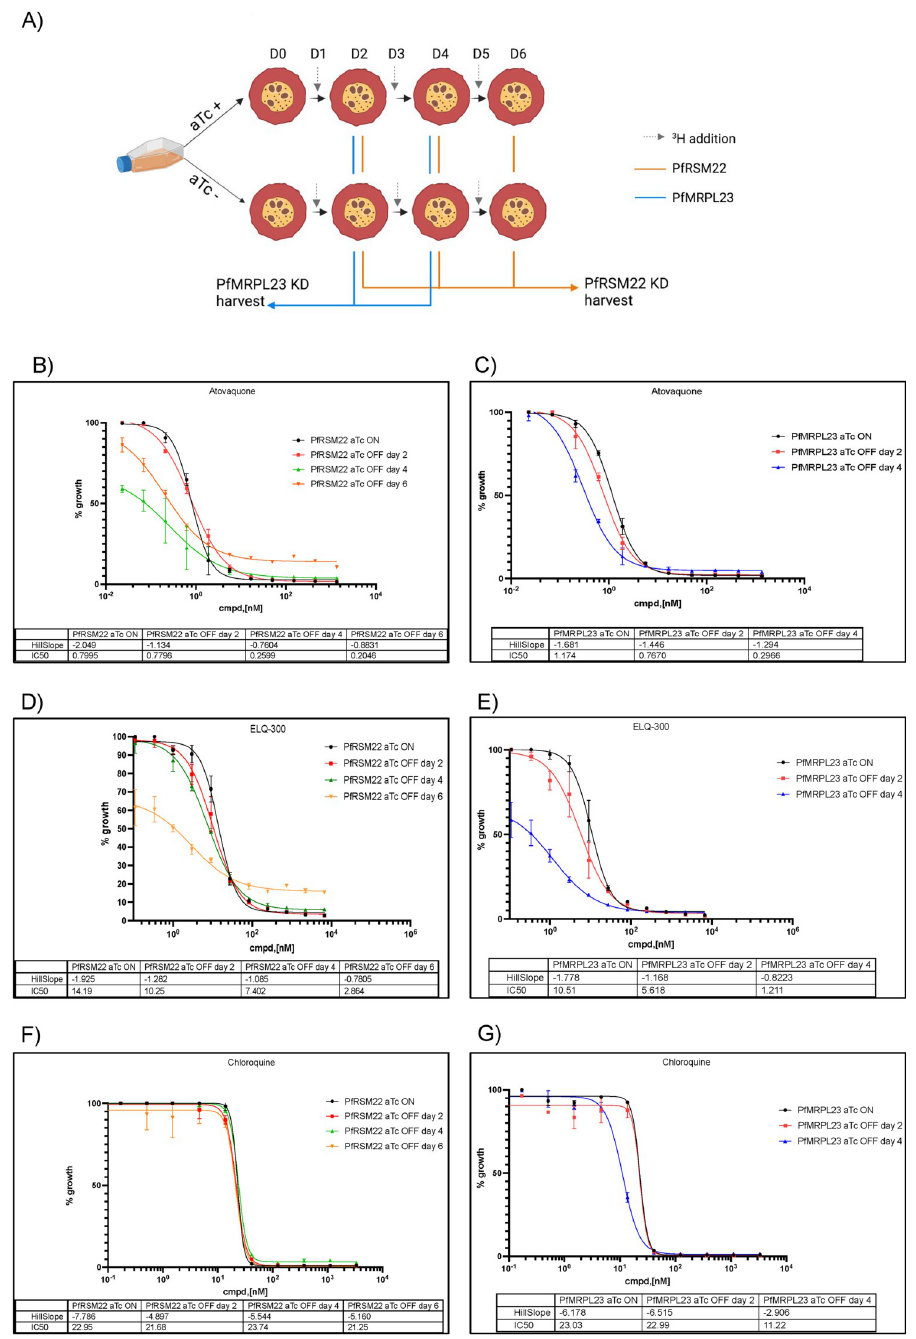
Fig 2. PfRSM22 and PfMRPL23 KD increased sensitivity to antimalarials targeting the parasite bc1 complex. (A) The schematic represents key steps of growth inhibition assays measured by [ 3 H] hypoxanthine incorporation. The diagram was created using BioRender.com. (B and C) Atovaquone hypersensitivity upon PfRSM22 and PfMRPL23 KD respectively. (D and E) ELQ-300 hypersensitivity upon PfRSM22 and PfMRPL23 KD respectively. Reduction in IC50 values and Hill Slope of the curve were reported for respective parasite lines. Data shown are the mean ± S.D. of triplicates from n = 3 independent experiments. (F and G) KD of PfRSM22 or PfMRPL23 did not show hypersensitivity to